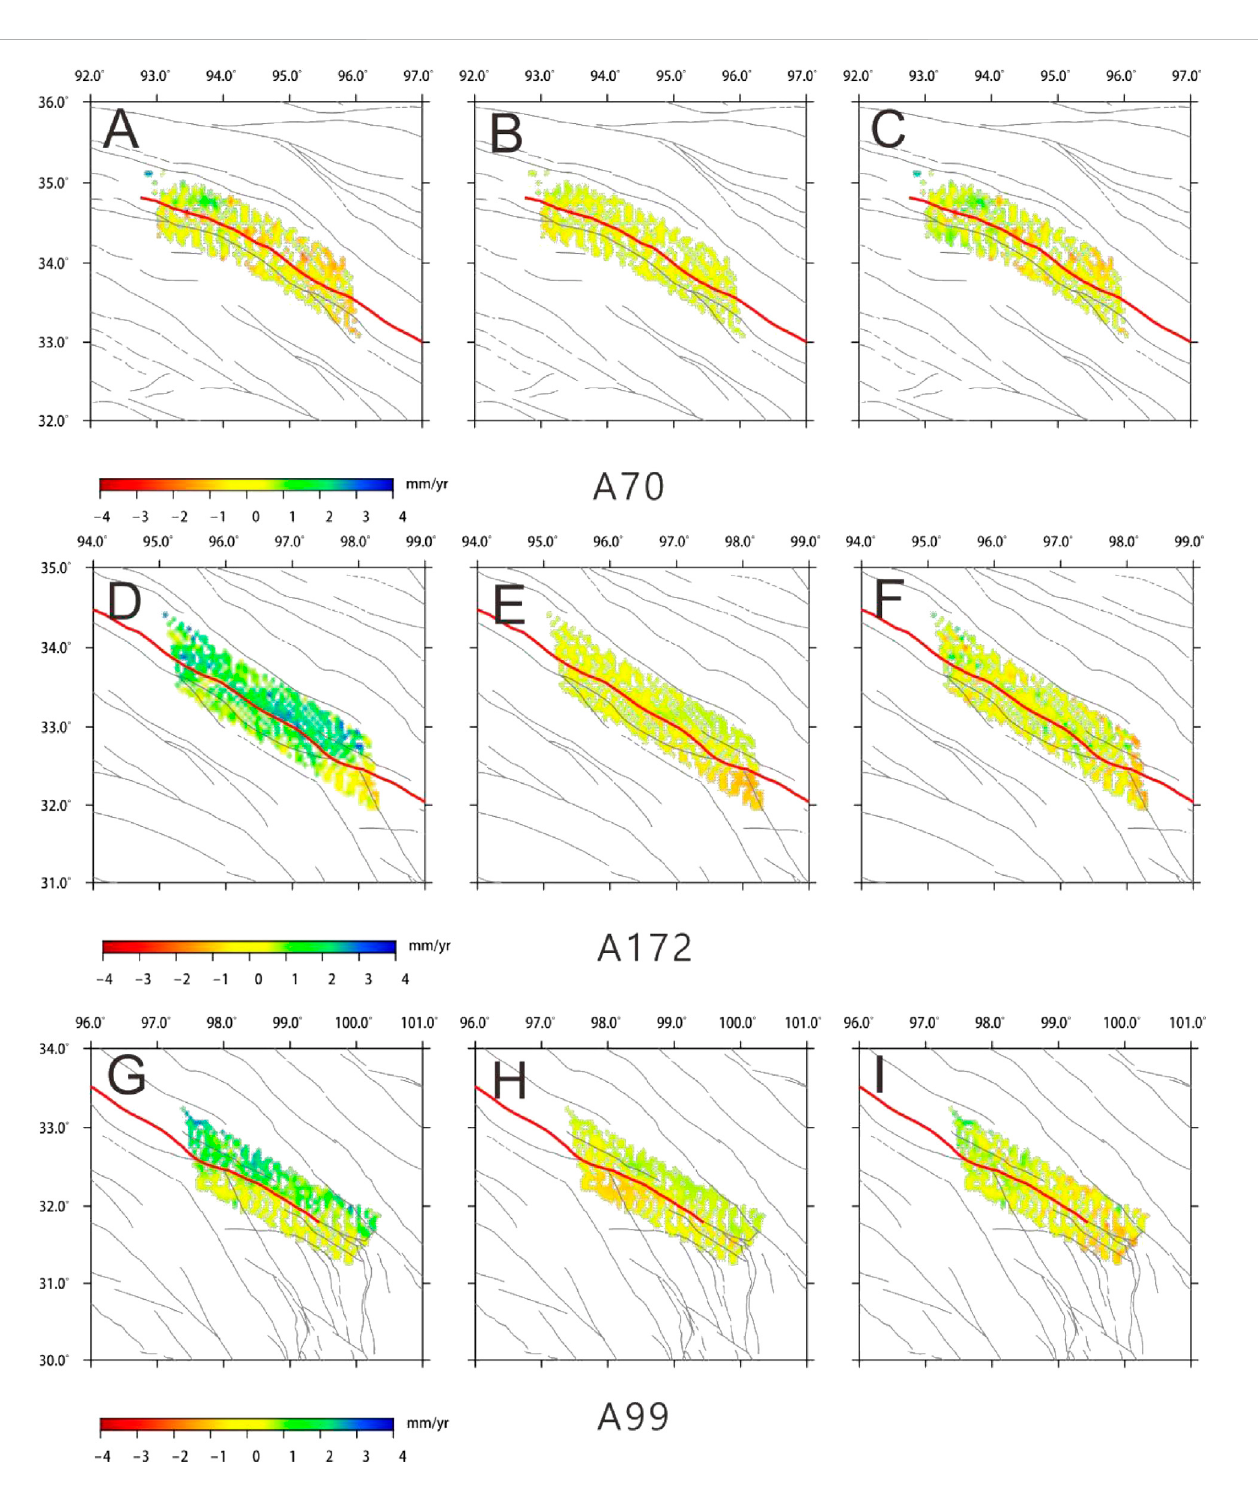
Modeling results obtained using ascending track data: (A, D, G) measured values, (B, E, H) simulated values, and (C, F, I)